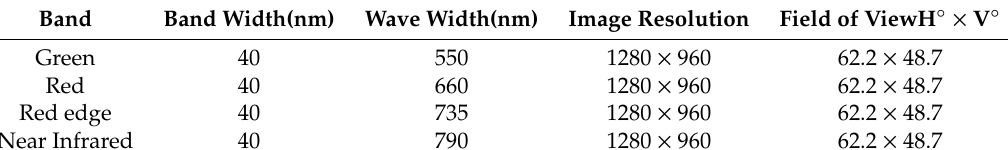
Table 2. Specification of the Sequoia multispectral sensor used in this study.